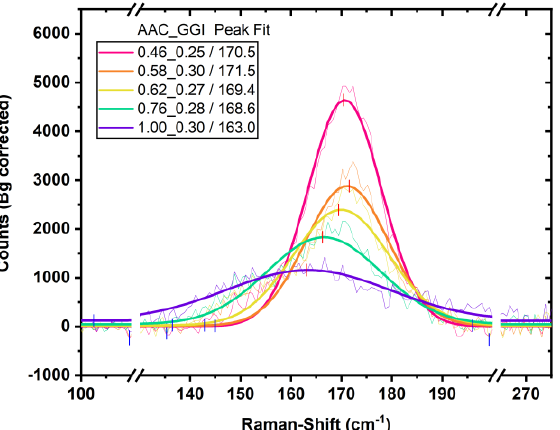
Figure 3. Raman signal of main A 1 mode for ACIGSe of different compositions as indicated. The fitted peak value in cm − 1 is also given.